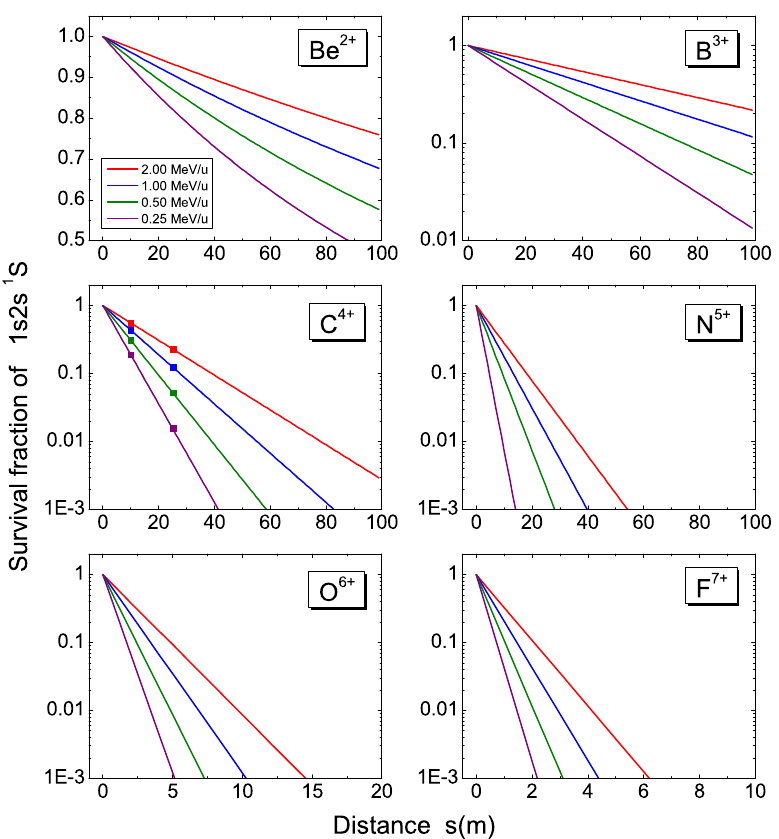
Figure 1. The surviving fraction of the 1 s 2 s 1 S metastable state as a function of the ion beam traveling distance s for various elements with 4 ≤ Z p ≤ 9 and typical projectile energies of 0.25–2 MeV/u. Lifetimes are from Ref. [66]. For these He-like ions the survival of the much longer lived 1 s 2 s 3 S metastable state (not shown) is practically 100% over the same